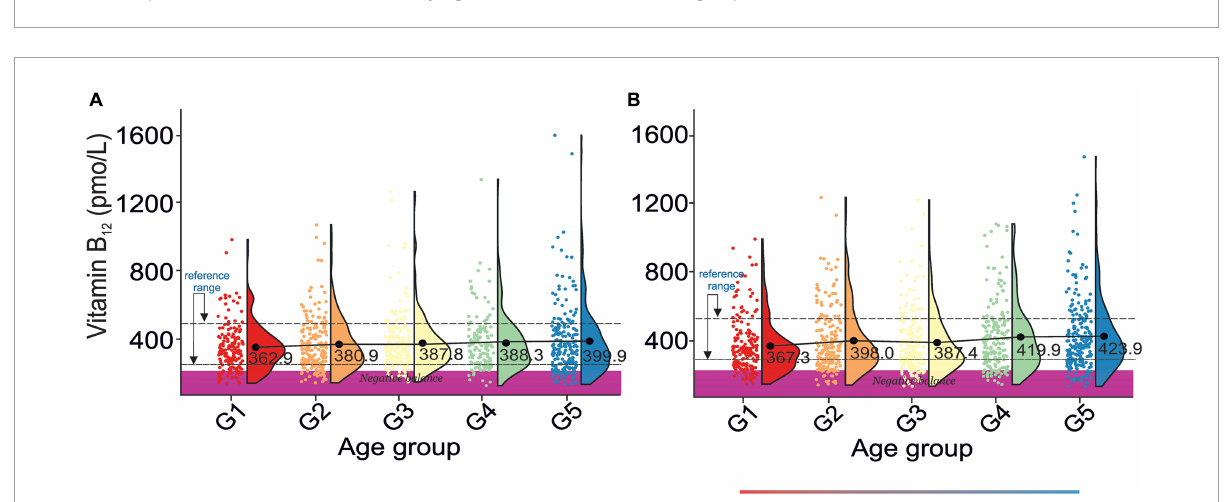
FIGURE5 Rain-cloud plots of age-dependent changes in vitamin B12 levels as a function of age group G1: 20 ≤ 1 < 30, G2: 30 ≤ 2 < 40, G3: 40 ≤ 3 < 50, G4: 50 ≤ 4 < 60, and 60 ≤ G5 < 70 years of age-stratified by gender (A) men, (B) women. Mean values for a specific sample are truncated to one decimal place. Color bars refer to statistically significant differences between groups at P < 0.05. Shaded area corresponds to vitamin B12 negative balance levels (82).